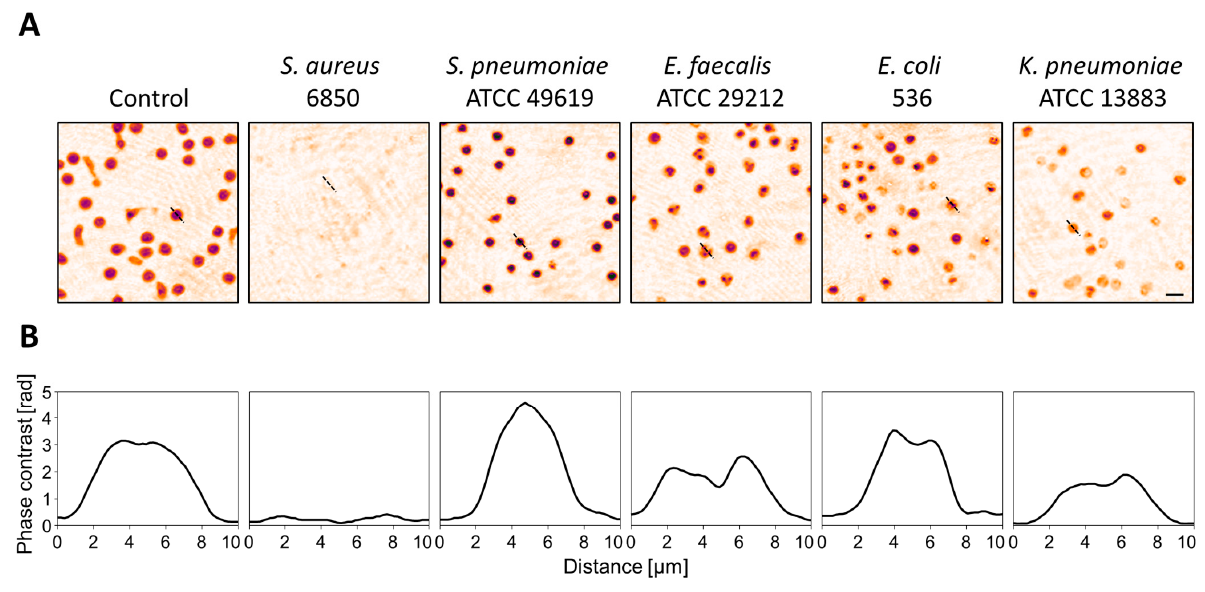
Figure 1. Distinct cell morphologies after exposure to bacterial culture supernatant derived from different species. Human primary T-cells were treated with sterile bacterial culture supernatants derived from various species or left untreated as control. DHM was applied to visualize morpho- logical changes. Representative images illustrating the cell morphology 10 h after the addition of supernatants are shown. ( A ) Pseudo-colored phase contrast images. The scale corresponds to 10 µm. ( B ) Distribution of phase contrast of cross-sections through single cells (black dashed line in A).